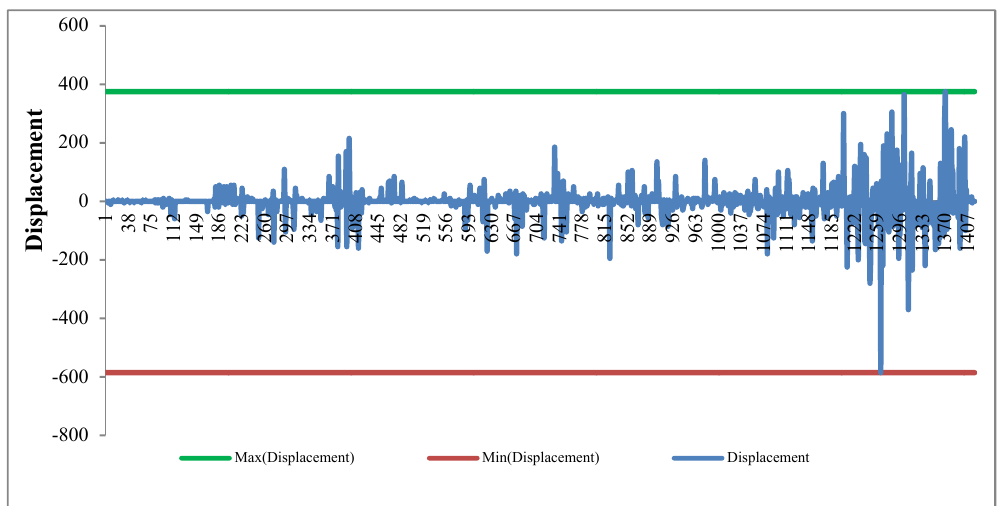
Figure 10. Difficulty of every slot allocation while weights set as [0,0,1] in test 3. Figure 10. Di ffi culty of every slot allocation while weights set as [0,0,1] in test 3.